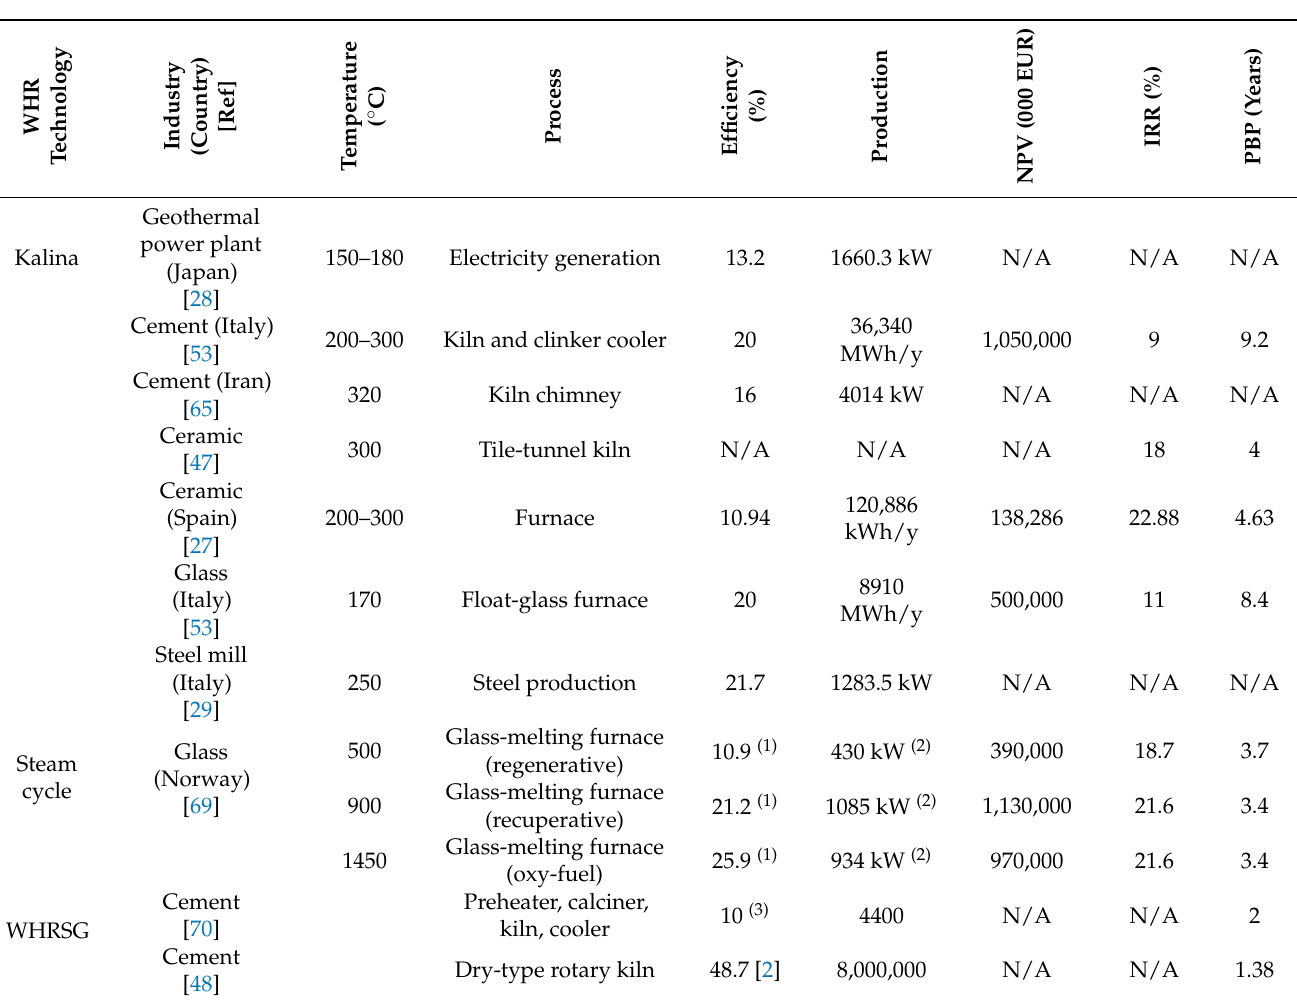
Table 2. Case studies for WHR